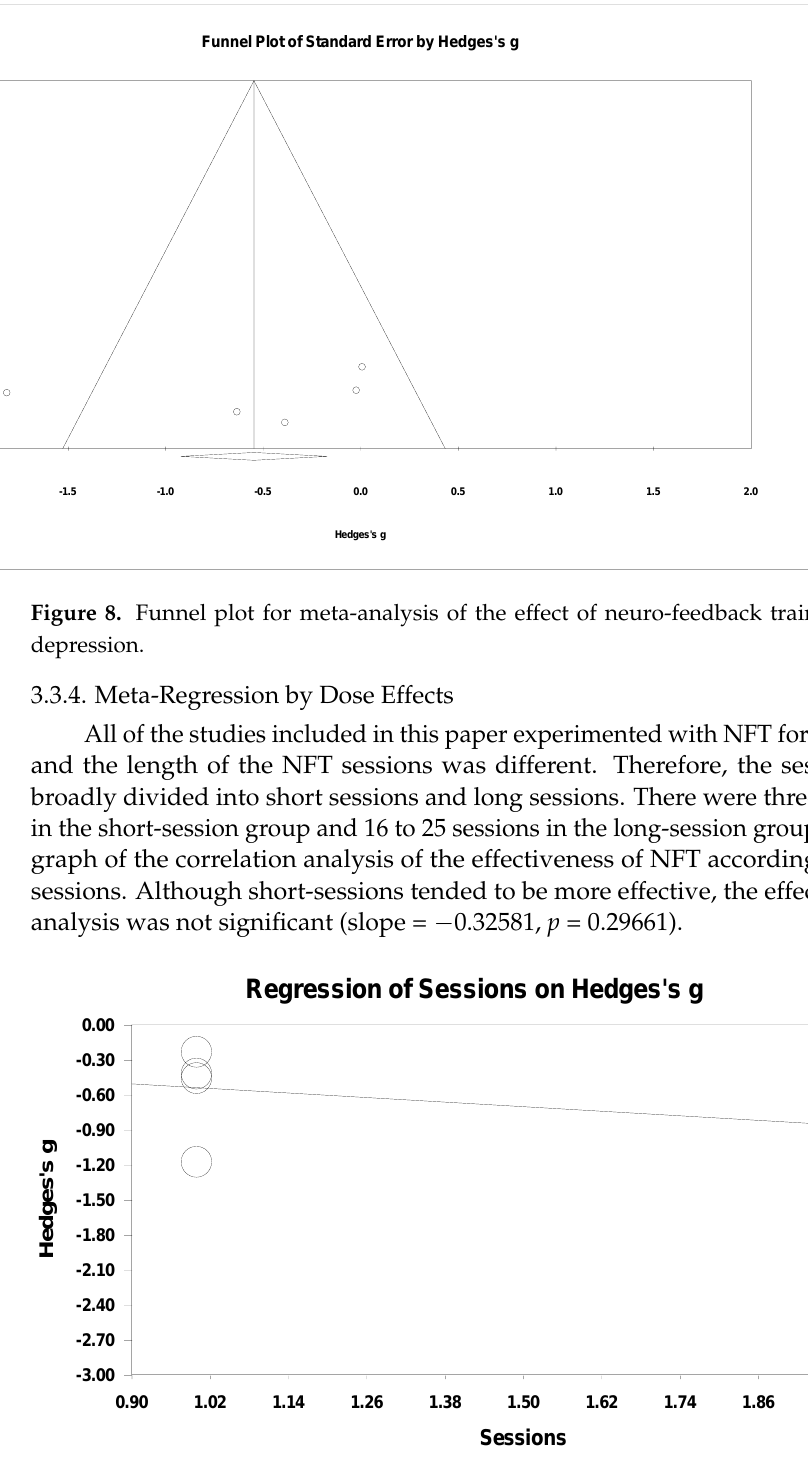
Figure 9. Meta- regression analysis of training sessions on Hedges’ s g.